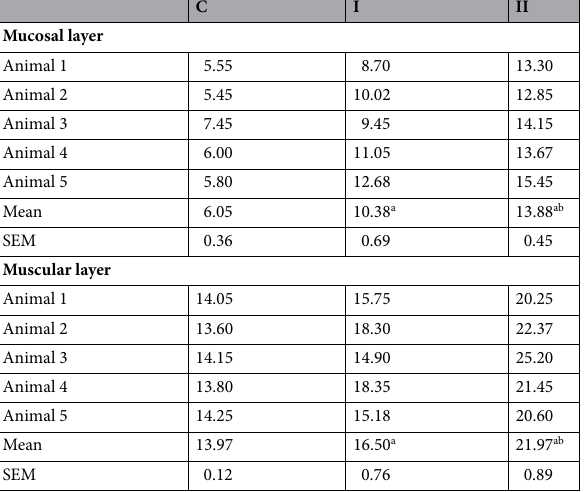
Table 2. The average number of nerve fibers immunoreactive to vasoactive intestinal polypeptide (VIP) per observation field (0.1 mm 2 ) in the wall of urinary bladder trigone in the control group (C), the experimental group I (I) and experimental group II (II). The results were considered statistically significant at p < 0.05 and are marked with a (statistically significant differences between group I or II and group C) or b (statistically significant differences between group I and II).